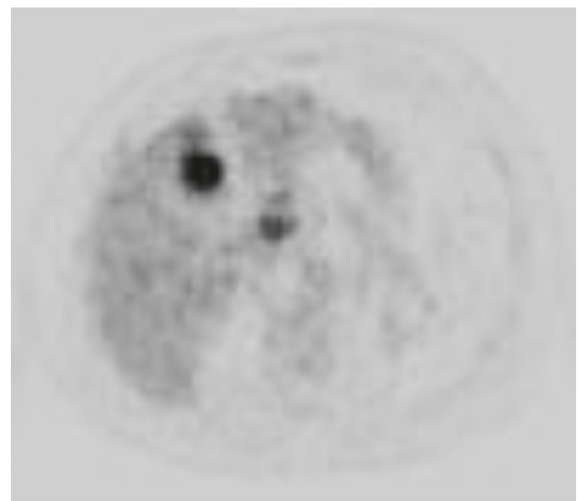
Figure 4: PET-CT demonstrated 3cm hypermetabolic liver mass seen on MRI.